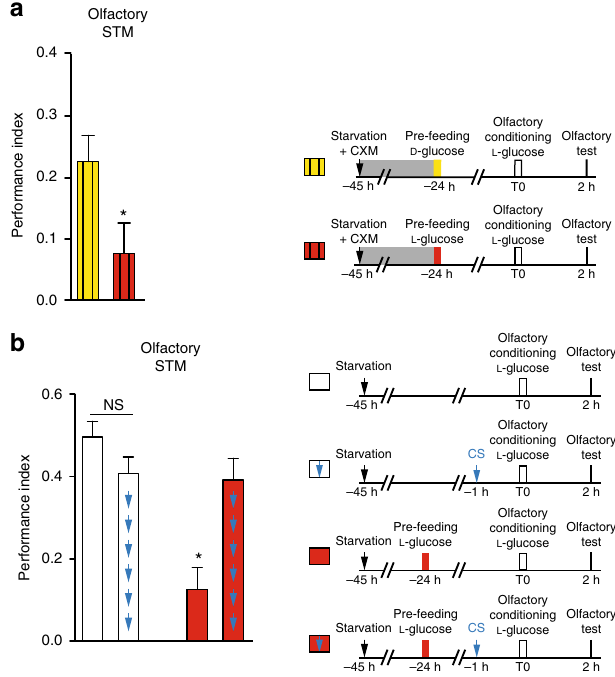
Fig. 2 CFM processing does not require de novo protein synthesis and is sensitive to anesthesia treatment. a Treating fl ies with the protein synthesis inhibitor CXM before pre-feeding does not alter the negative effect of L - glucose pre-feeding ( t -test, t 37 = 2.301; p = 0.027; n ≥ 19). b Cold-shock application 1 h prior to olfactory conditioning did not impair the 2-h olfactory memory scores ( t -test, t 22 = 1.592; p = 0.125; n = 12). Flies pre-fed with L -glucose and conditioned with L -glucose display lower olfactory memory scores as compared to non-pre-fed fl ies ( t -test, t 22 = 5.687; p < 0.001; n = 12). Applying cold shock treatment to fl ies pre-fed